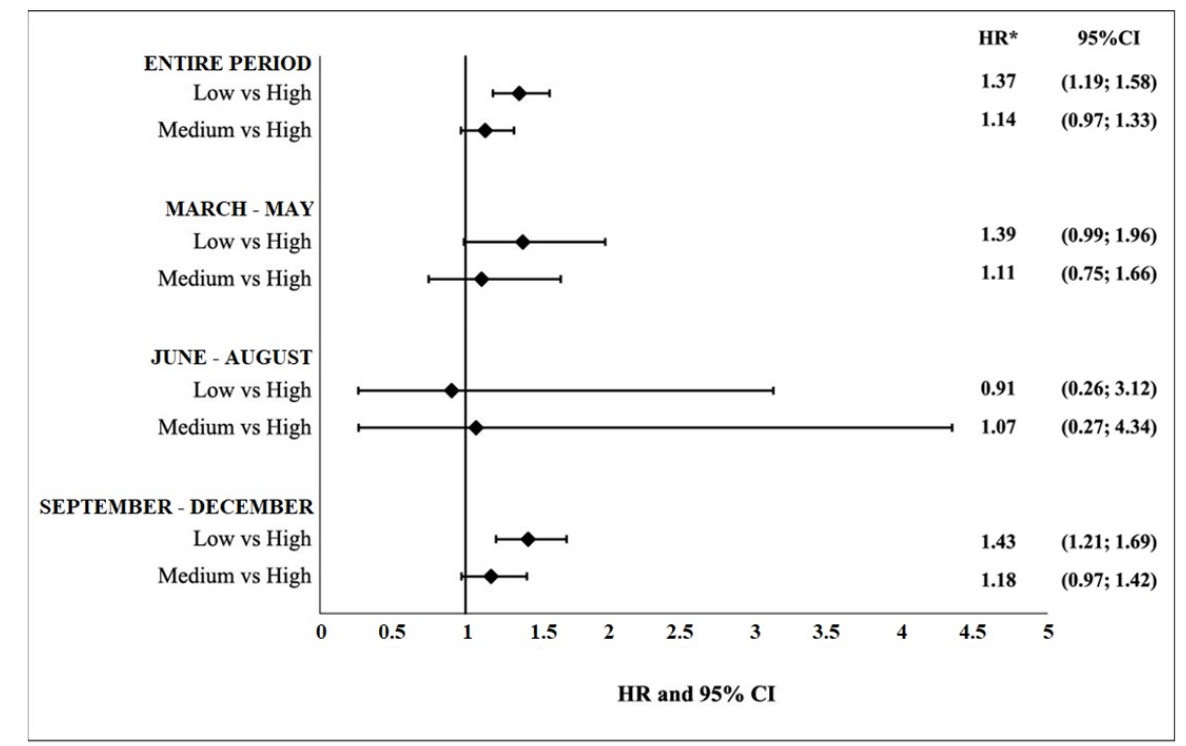
Figure 3. Association between educational level and mortality within 30 days of the onset of SARS- CoV-2 infection for the entire period and in the three phases of the pandemic.